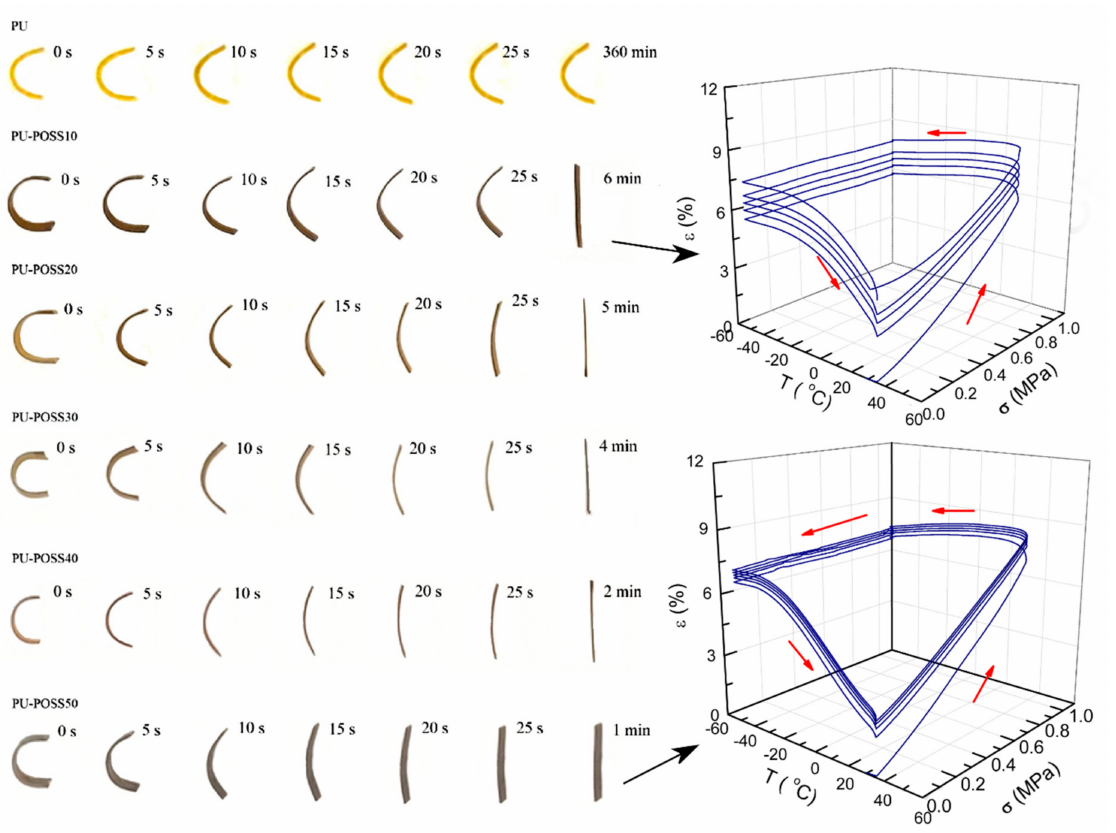
Figure 9. ( Left ): Shape recovery of samples with loadings of POSS from 0% to 50% ( Right ): changes in strains of one–way shape memory cycles for the lowest and the highest loadings of POSS. Reprinted with permission from Zhao, B.; Xu, S.; Adeel, M.; Zheng, S. (2019) Polymer,